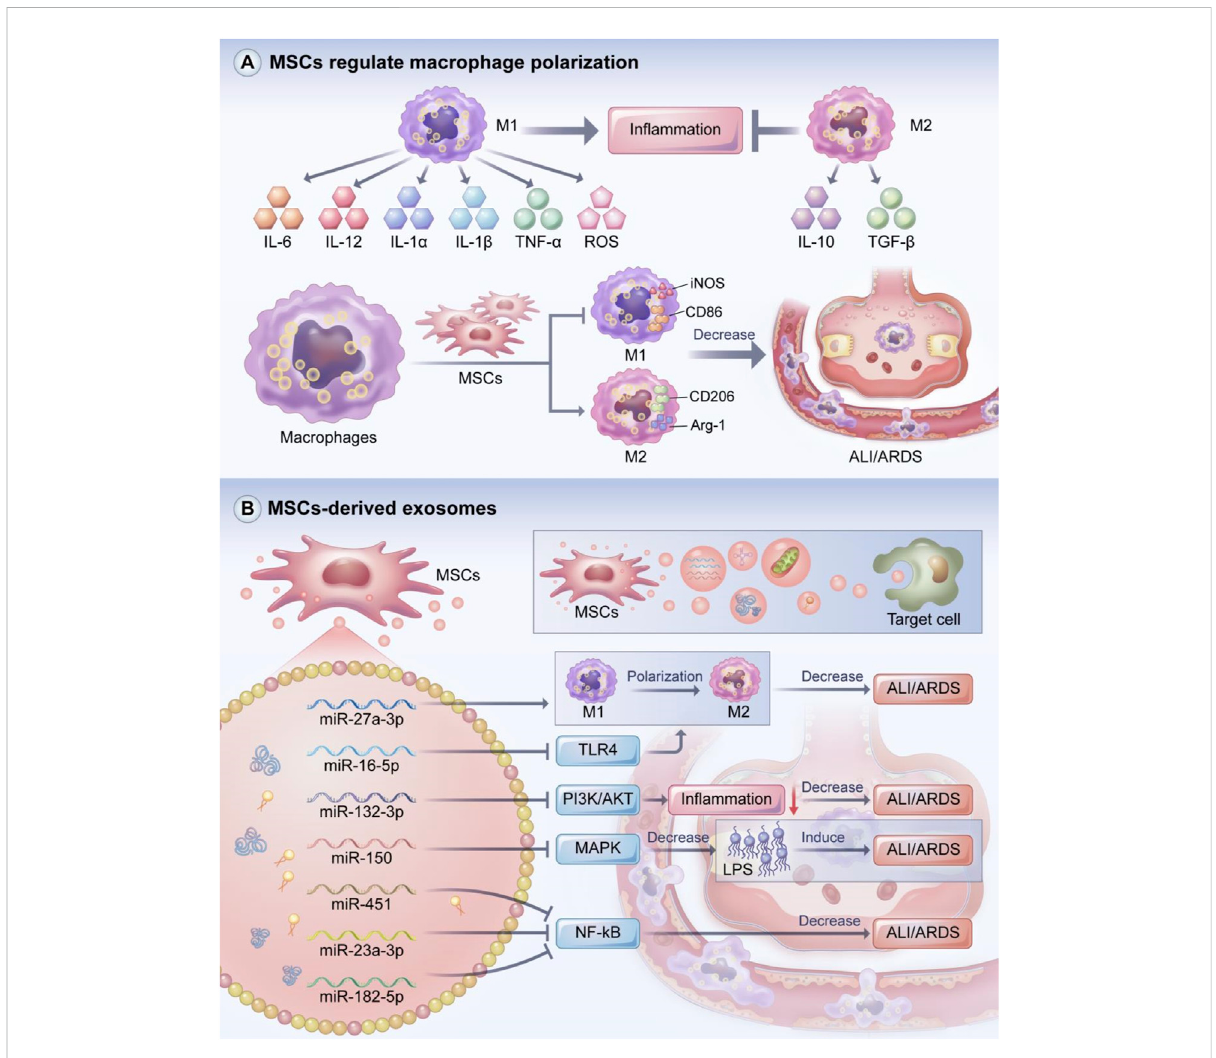
FIGURE 4 MSCs regulate macrophage polarization and the role of MSCs-derived exosomes. Macrophages include M1 and M2 macrophage phenotypes, with M1 macrophages exerting a pro-in fl ammatory effect and M2 macrophages acting as an inhibitor of in fl ammation. MSCs can promote M2 macrophage polarization while suppressing M1 macrophage polarization to attenuate the in fl ammatory response in ALI/ARDS. MSCs-derived exosomescantransfermRNA,miRNA,proteins,lipidsandevenmitochondriatotargetcellsandtissues,playingakeyroleinimmuneregulation of in fl ammatory responses. The miRNA carried in MSCs-derived exosomes can promote M2 macrophage polarization to alleviate ALI/ARDS. In addition, MSCs-derived exosomal miRNA can improve ALI/ARDS by regulating PI3K/AKT, MAPK, NF-kB and other signaling pathways. (A) MSCs regulate macrophage polarization and the role of (B) MSCs-derived